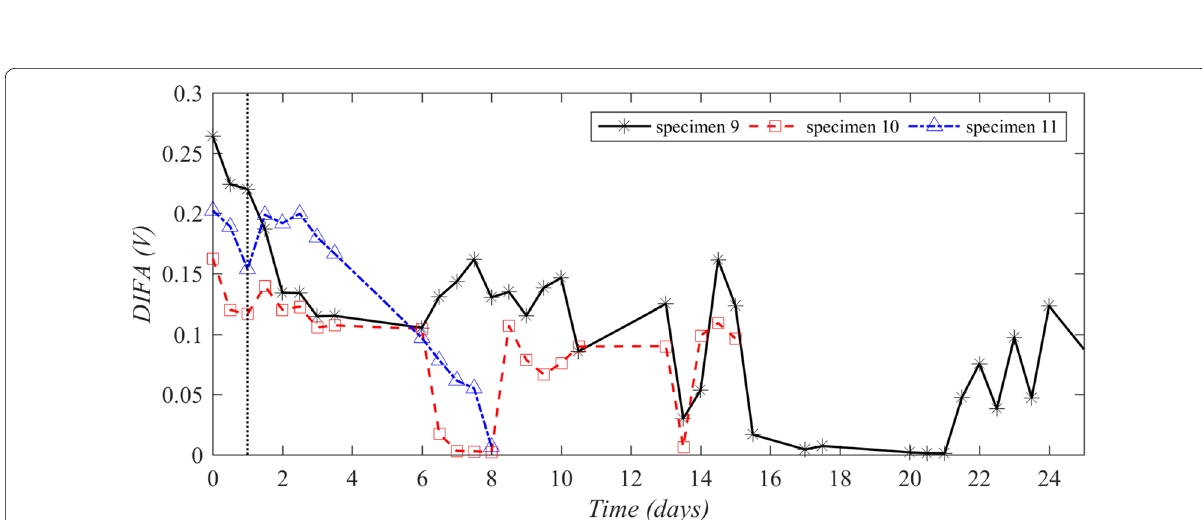
1 day) indicates the onset of the accelerated corrosion test. =